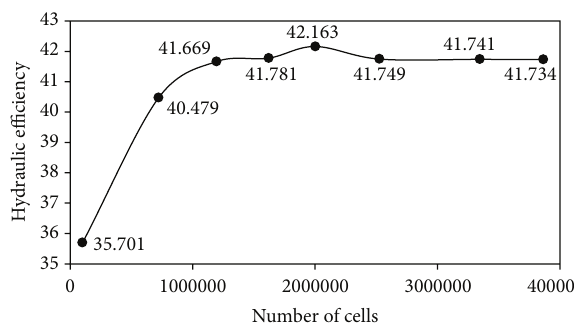
Figure 6: Hydraulic efficiency versus number of